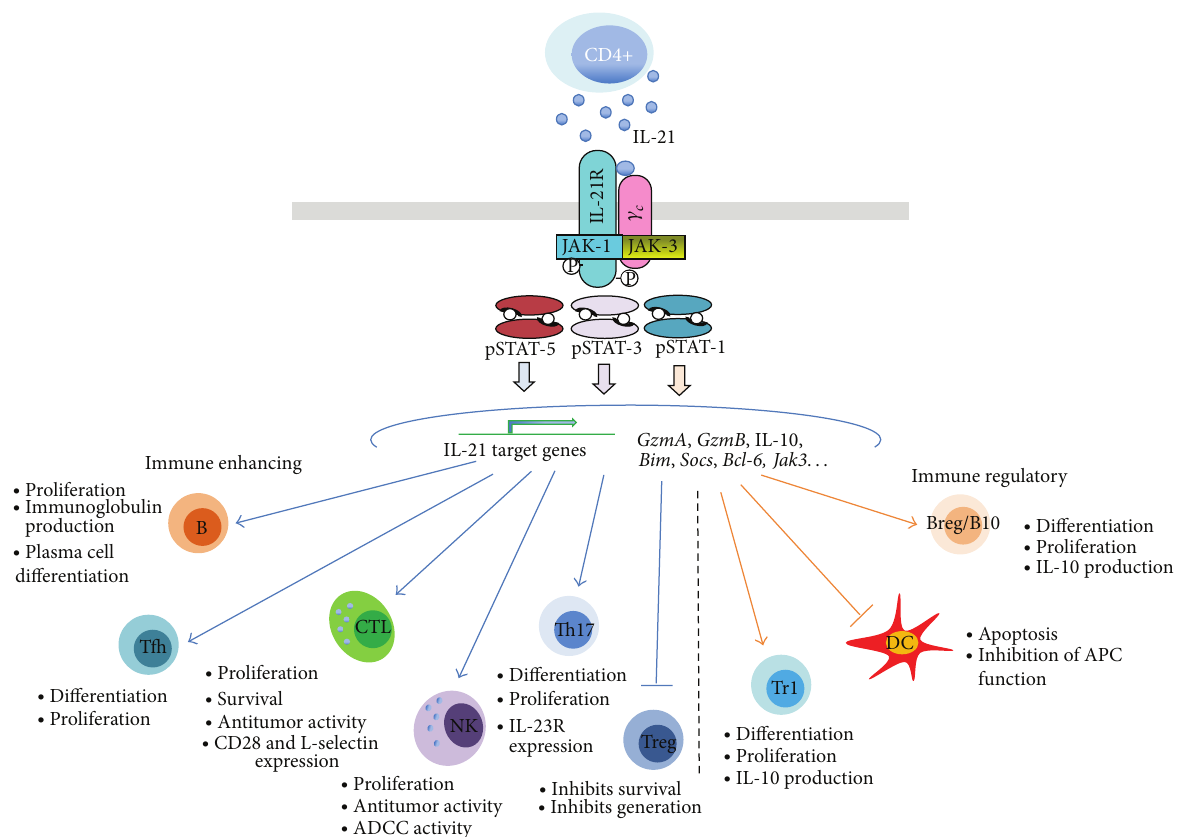
Figure 1: Schematic representation of IL-21 signaling pathways and its main biological effects on different target